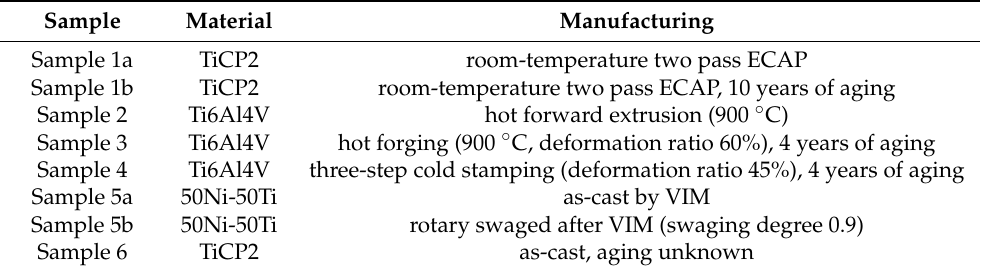
Table 2. Characterization of individual samples and their preparation methods.